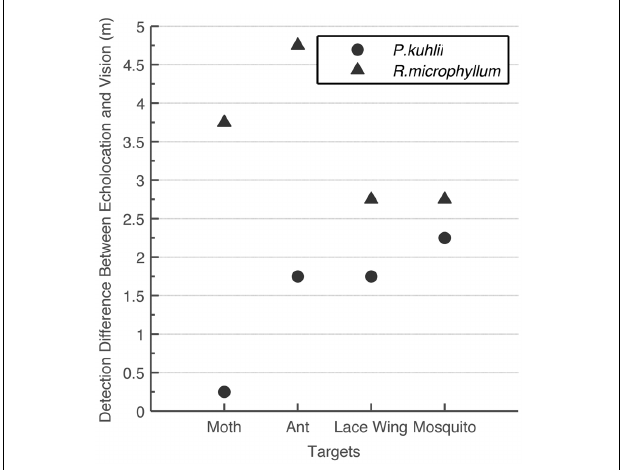
FIGURE 3 | Comparison between visual and echolocation detection ranges. The difference (in meters) between echolocation detection range and the visual detection range for two bat species and four insects. In all cases echolocation detection range was higher than visual detection range.